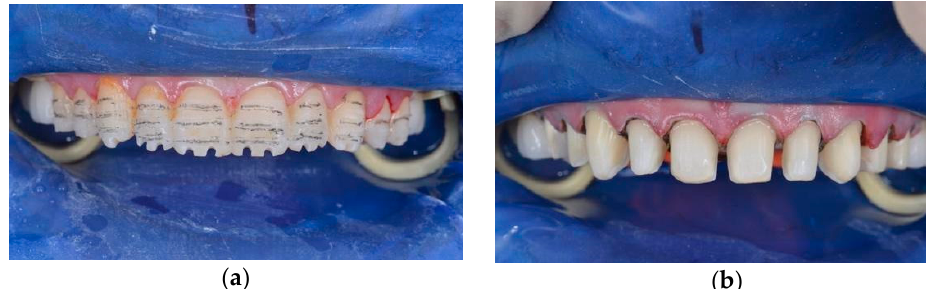
Figure 11. Teeth preparation ( a , b ).